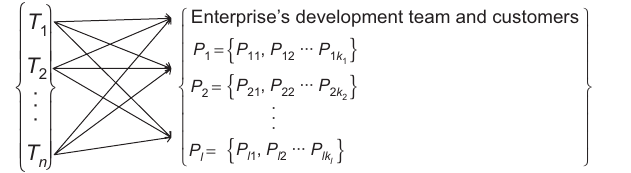
Figure 2. The Mapping Relationship Diagram of Product Customization Development Task